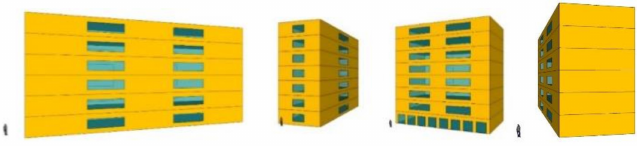
Figure 2. Building geometric 3D